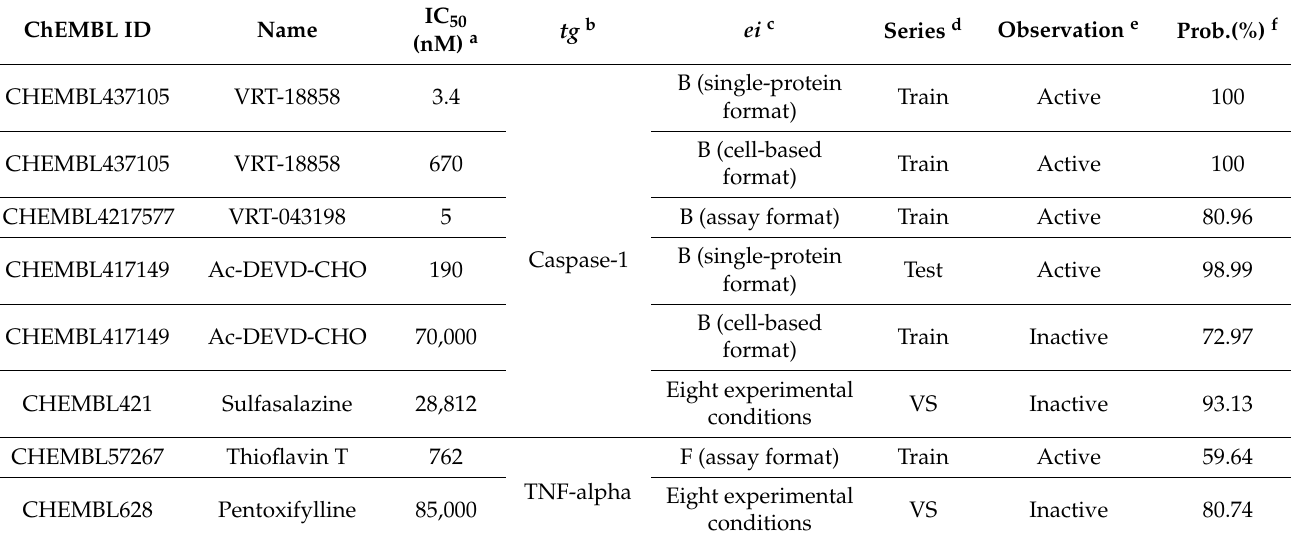
Table 4. Different drugs or drug-derived chemicals correctly predicted by the mtc-QSAR-MLP model as protein inhibitors according to their experimental IC 50 values reported in the ChEMBL database.